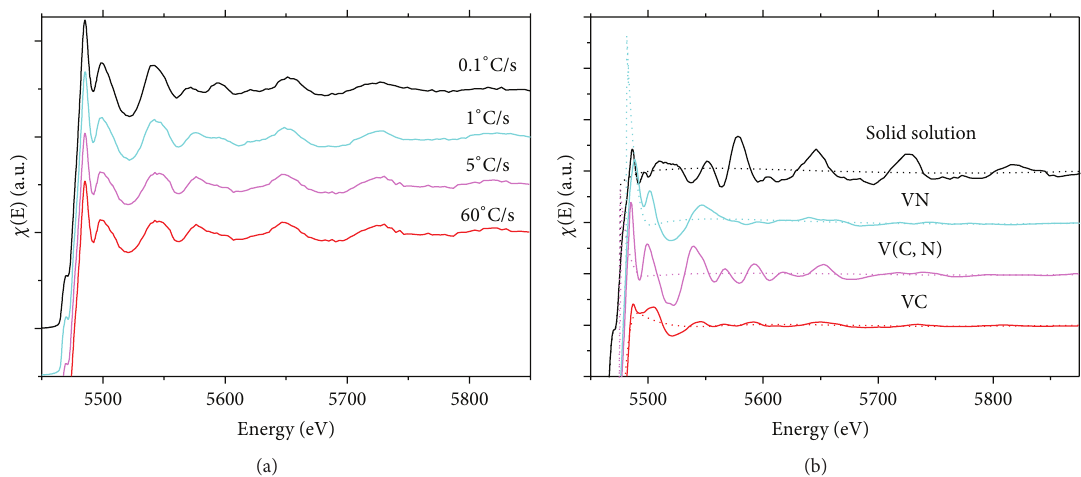
Figure 2: XAS spectra of (a) simulated hot rolled samples with different cooling rates, compared with (b) standard compounds of Vanadium and a sample in which Vanadium is completely dissolved.